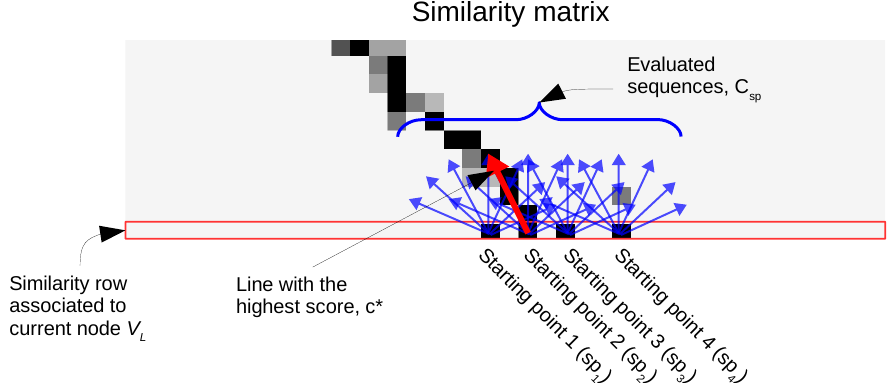
Figure 5. Given a similarity matrix ¯ S , we look for the starting points with scores greater than the threshold µ in the last row. Then, we evaluate the score for every predefined line in C translated to each ) ). The winning sequence c ∗ is the one with highest score from all sequences. starting point ( ( i sp , j sp k k In this example is the matching sequence starts in point